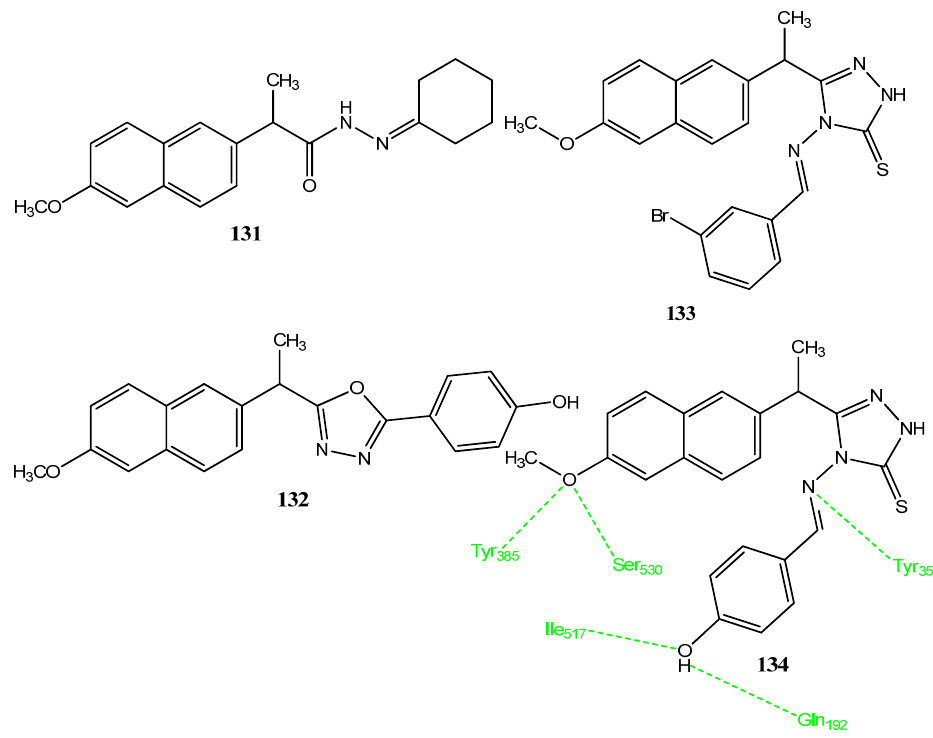
Figure 26. The derivatives of naproxen and their connection with COX-2.